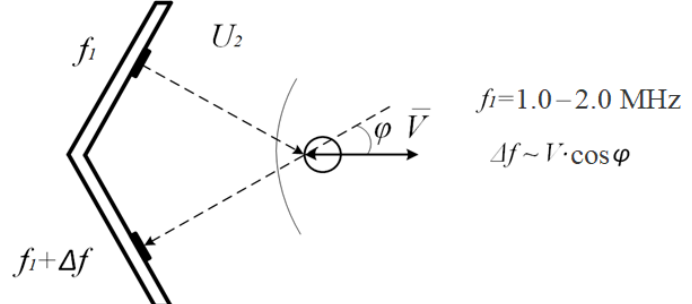
Figure 1. A sensor that uses the Doppler effect to detect the speed of movement V by changing the radiation frequency, f is the initial frequency of ultrasound, and f is the change in frequency by the Doppler effect.